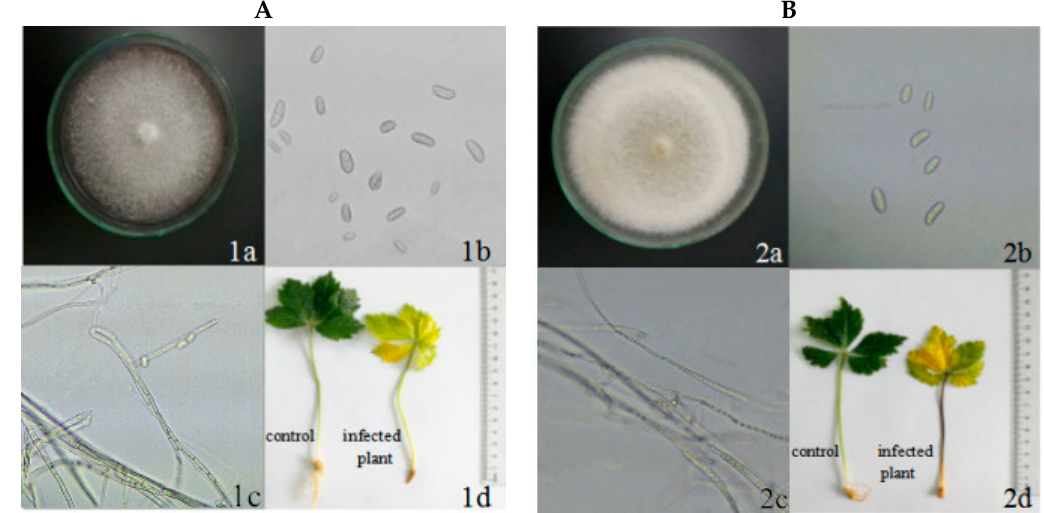
Figure 1. Microscopic observation of F . oxysporum, F . solani and infection of P . notoginseng . ( A ): F . oxysporum . ( B ): F . solain. (a) colonial morphology; (b) microconidia; (c) mycelium form; (d) P . notoginseng plants infected by pathogenic